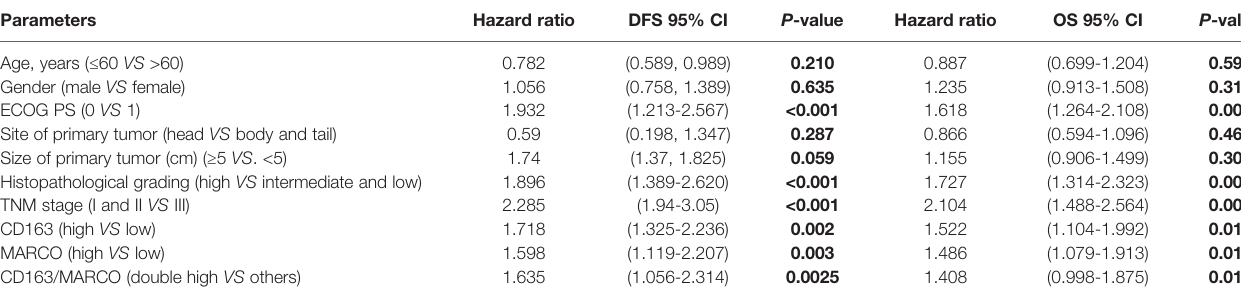
TABLE 3 | Univariate analysis.